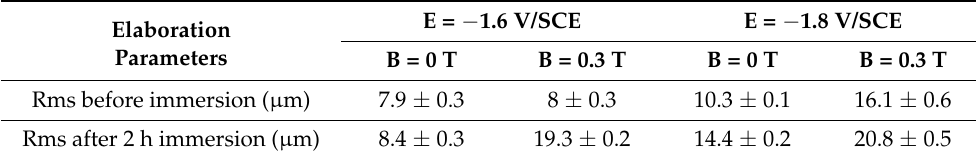
Table 4. Roughness values of the coatings elaborated during 30 min before and after 2 h immersion in 3.5%